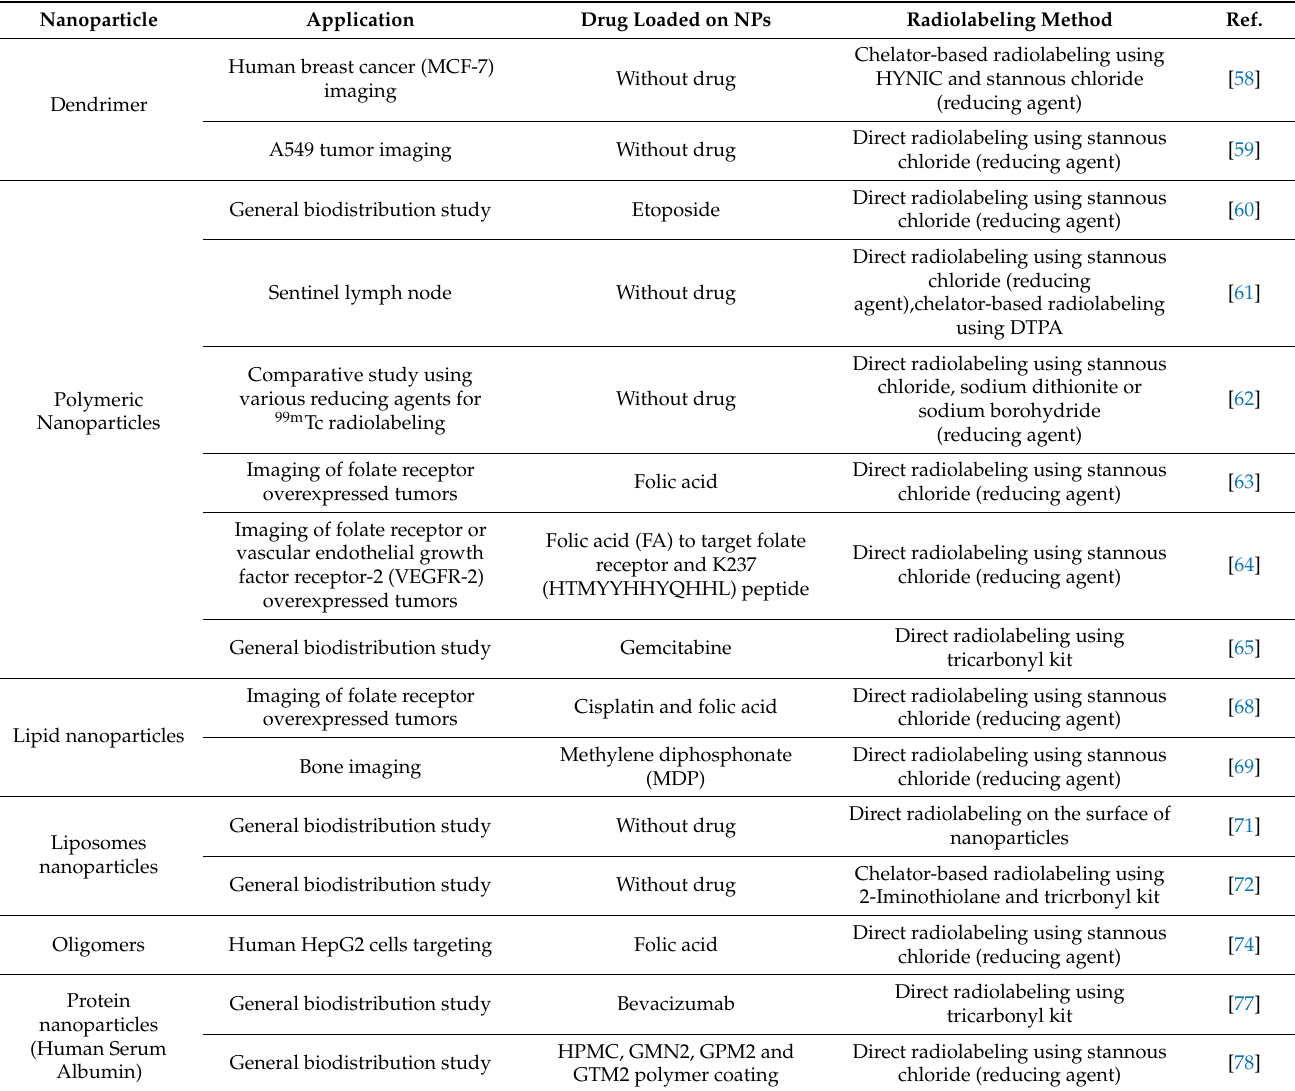
Table 3. Summary of 99m Tc-labeled organic nanoparticles and their